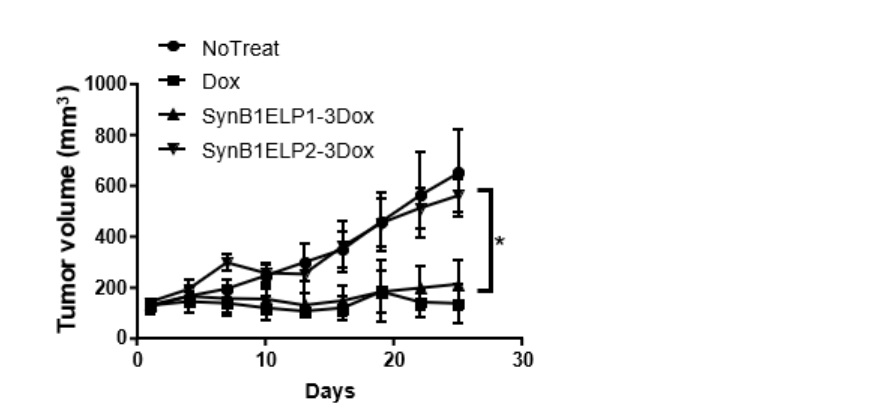
Figure 7. Tumor reduction of SynB1-ELP1-DOXO in MDA-MB-231 xenograft model. SynB1-ELP1- DOXO reduced the growth rate significantly comparing to control and SynB1-ELP2-DOXO treatment (on Day 25). Data were expressed in mean ± SD, *: p <